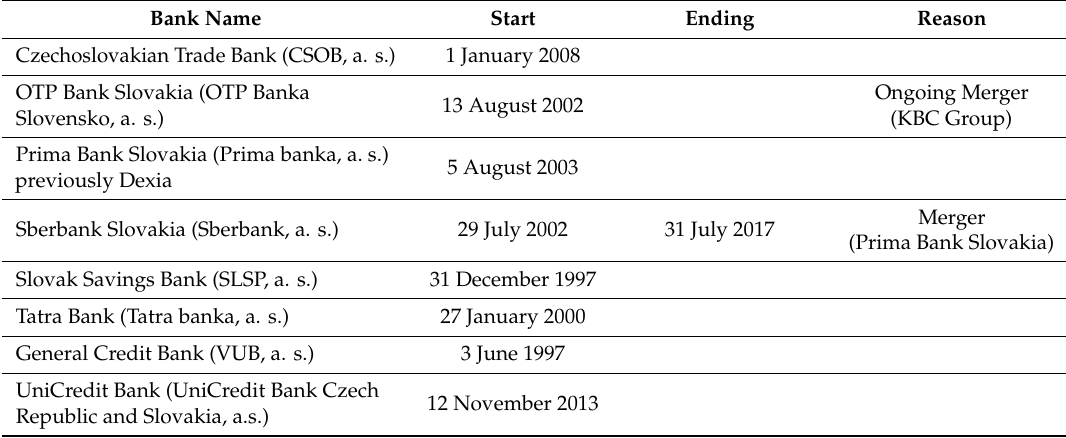
Table 3. Banks with license for mortgage banking in Slovakia (to 31 December 2017). Bank